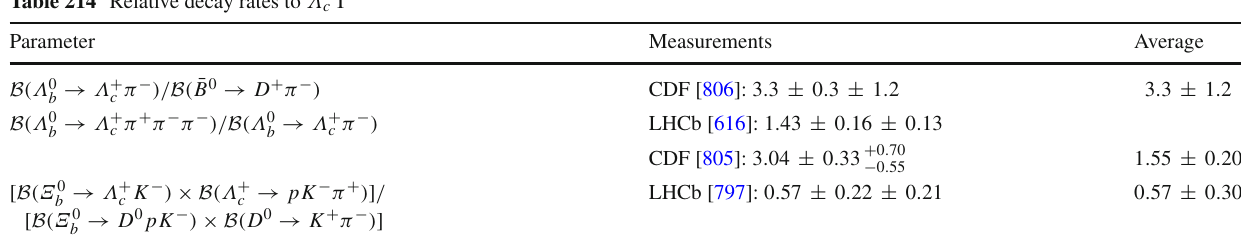
Table 214 Relative decay rates to Λ c I